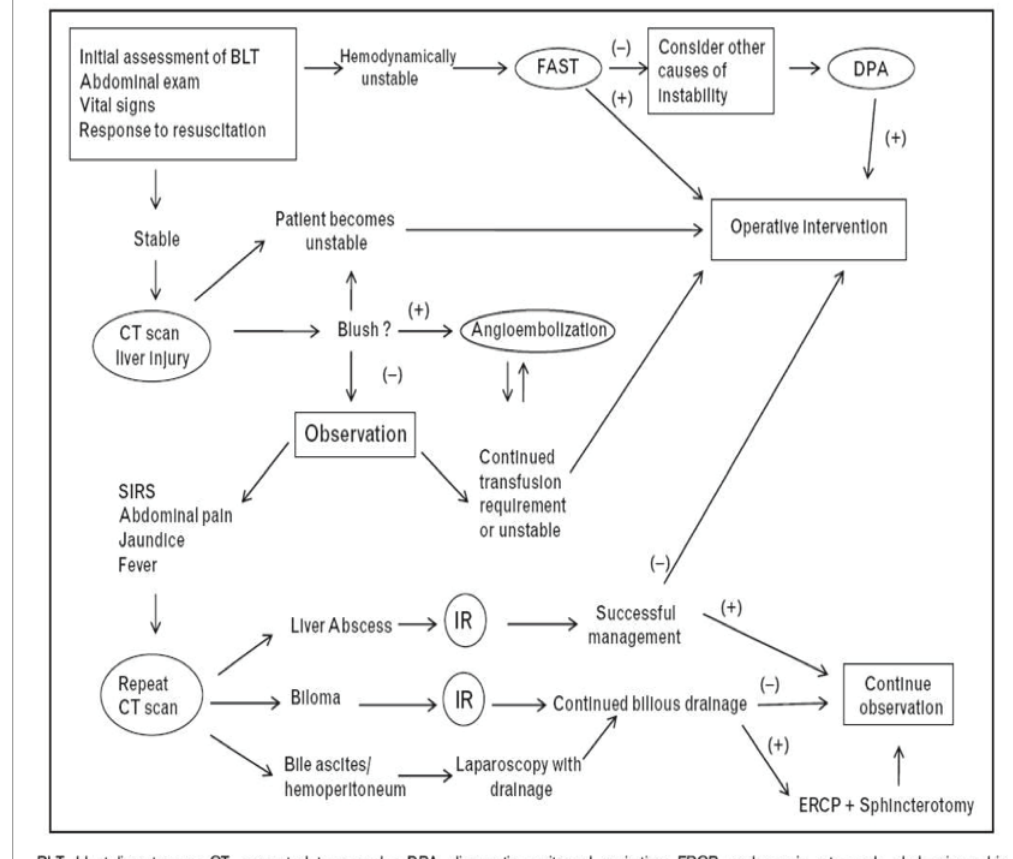
Figure 1: Algoritm for non operative management in blunt liver